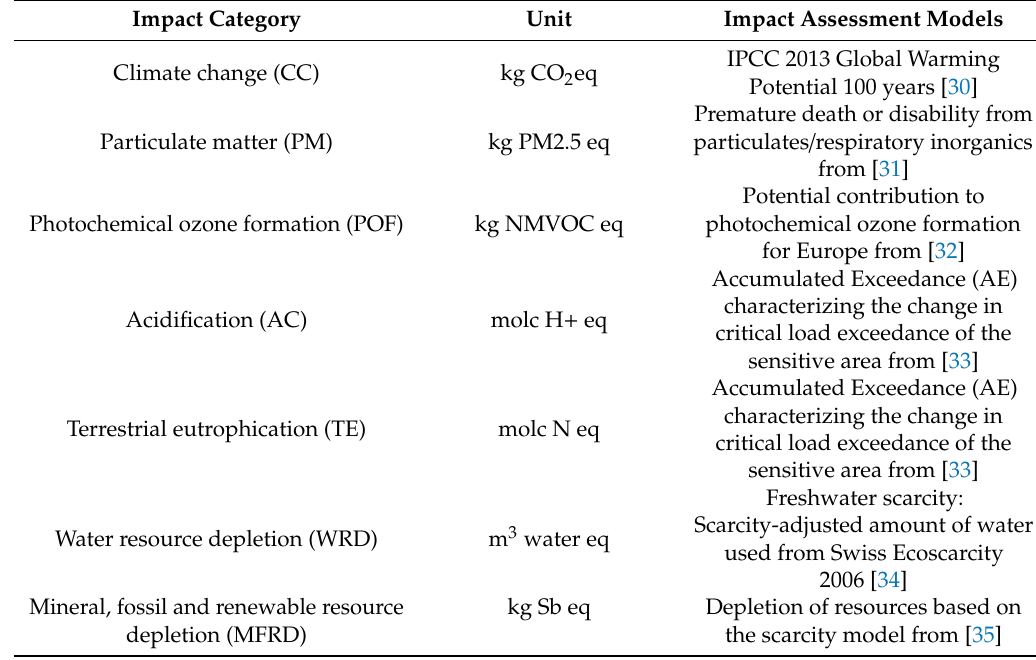
Table 1. Selected impact categories and models.